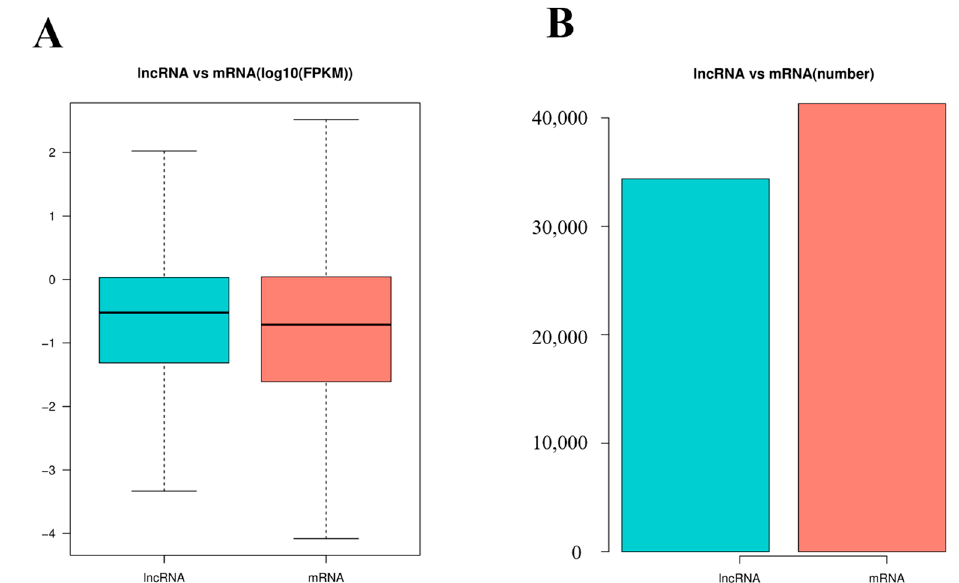
Figure 3. The expression levels and amounts of lncRNAs and mRNAs. ( A ) Boxplots of lncRNAs and mRNAs expression levels [with log10 FPKM (Fragments per Kilobase Million) method] in the control group and treatment group. ( B ) The numbers of lncRNAs and mRNAs in mouse spleens in the control group and treatment group.